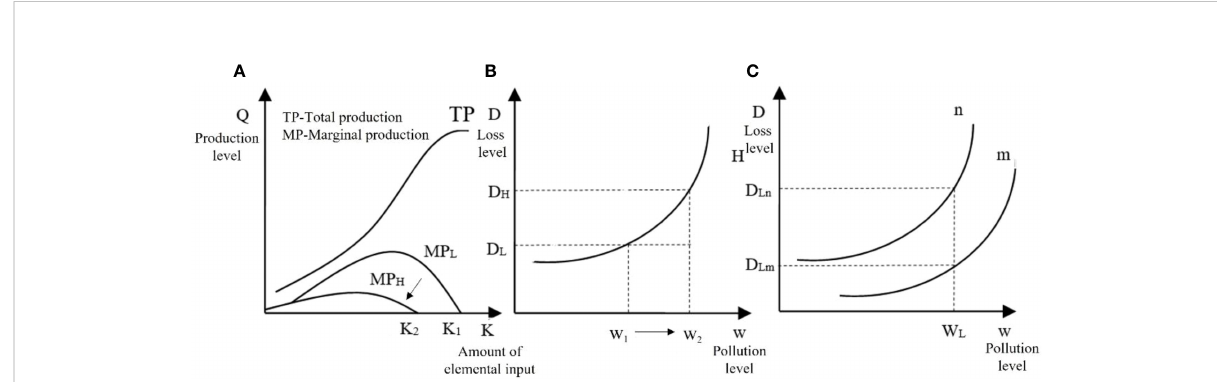
FIGURE 1 Differences in marginal damage from pollution and impacts. (A) Total Production vs. Marginal Production Curve. (B) The graph of the relationship between the degree of pollution and the level of loss. (C) The graph of individual heterogeneity analysis in the same pollution